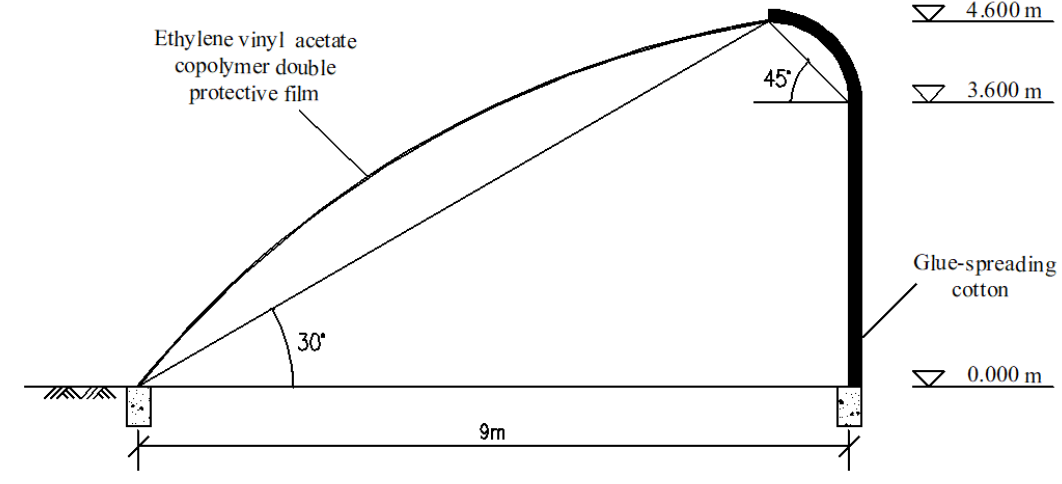
Figure 1. Cross section of the solar greenhouse. Table 1. Soil texture and soil hydraulic property at the experimental